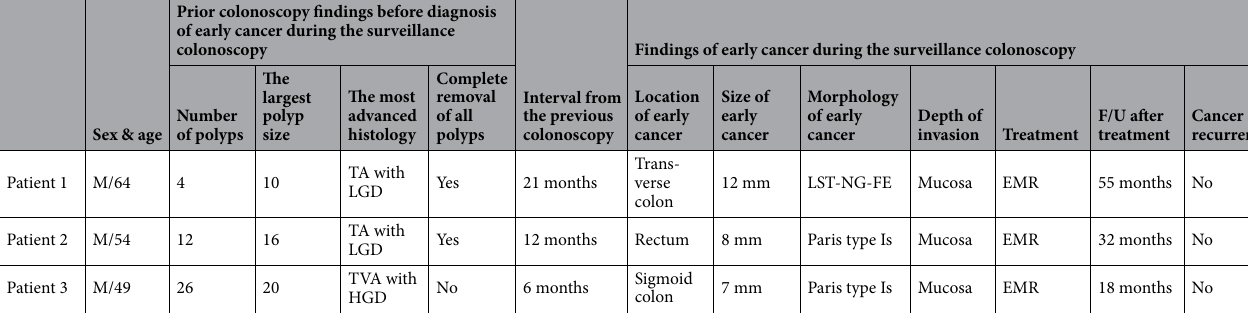
Table 4. Summary of three patients diagnosed with early cancer during surveillance colonoscopies. EMR endoscopic mucosal resection, F/U follow-up, HGD high-grade dysplasia, LGD low-grade dysplasia, TA tubular adenoma, TVA tubulovillous adenoma, LST-NG-FE laterally spreading tumor-non granular-flat